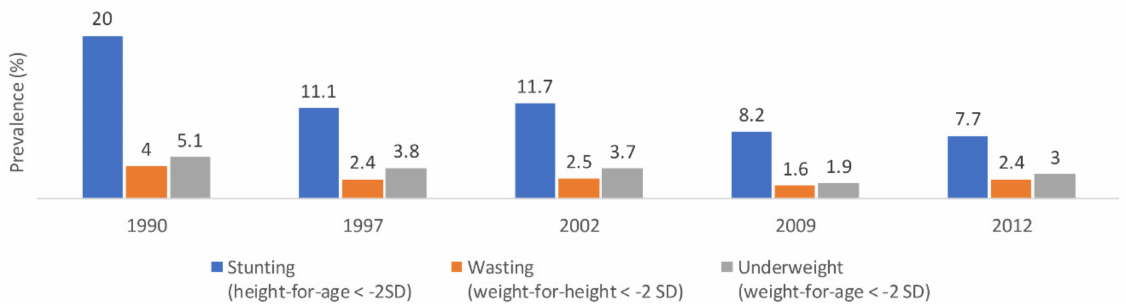
Figure 3. Trends in the prevalence (%) of stunting, wasting, and underweight among children under 5 years in Jordan, national surveys (1990–2012). Abbreviations: SD: standard deviation. Source: UNICEF, 2021